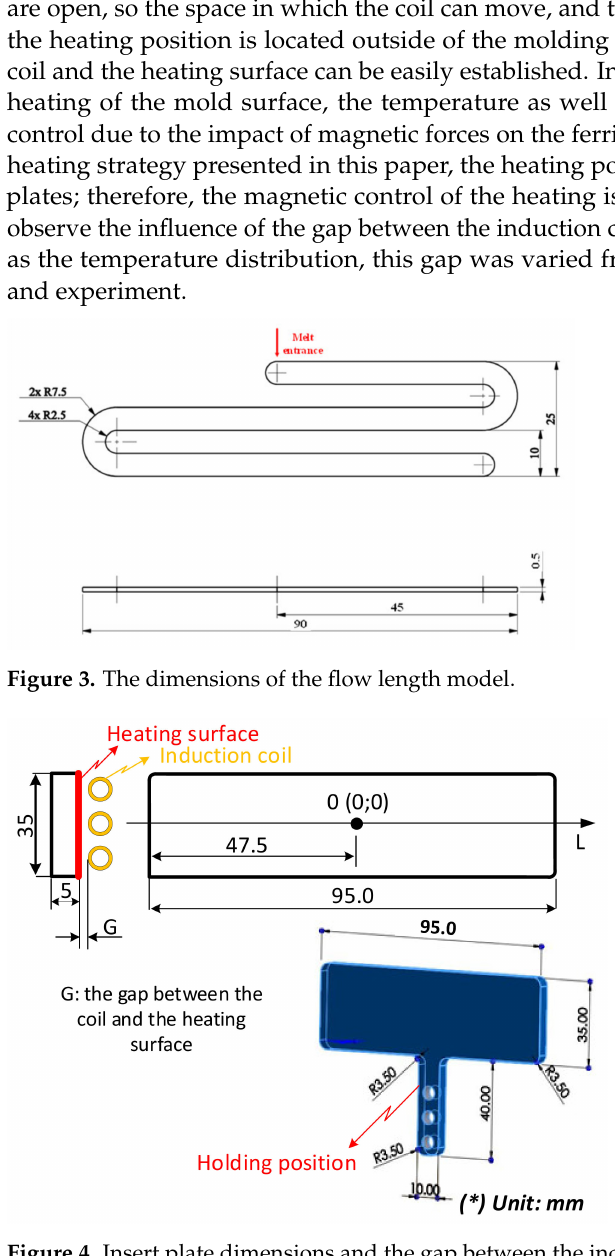
Figure 4. Insert plate dimensions and the gap between the induction coil and heating